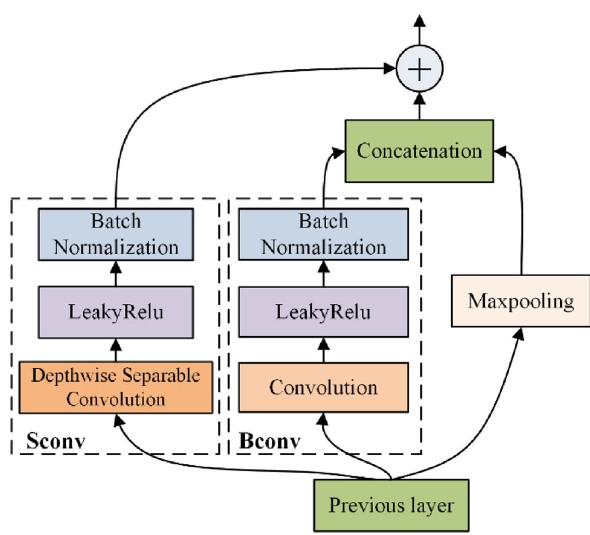
toobtaintheoverallfeaturefrompartialinformationaggrega- tion,andthenanattention-basedBLSTMmoduleissupposed